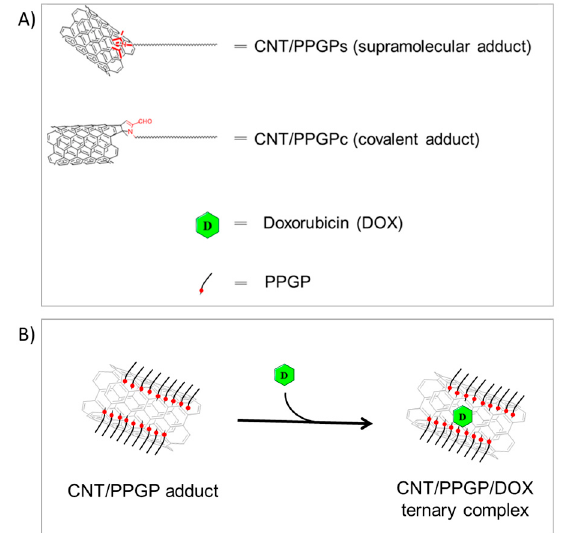
Figure 9. Representation of ( A ) the CNT/PPGP adducts, and ( B ) the hypothesized ternary complex CNT/PPGP/DOX.